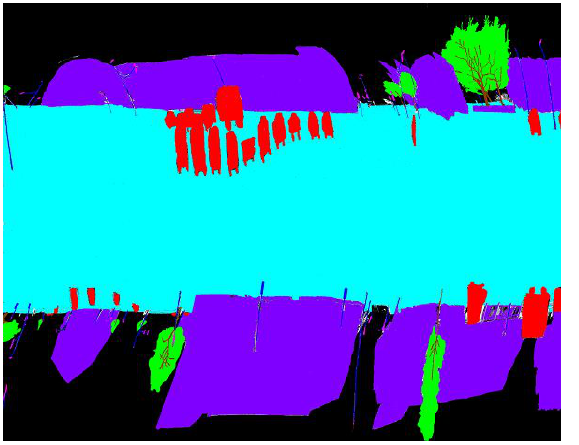
Figure 6: Cross section of the urban area classified after PCA